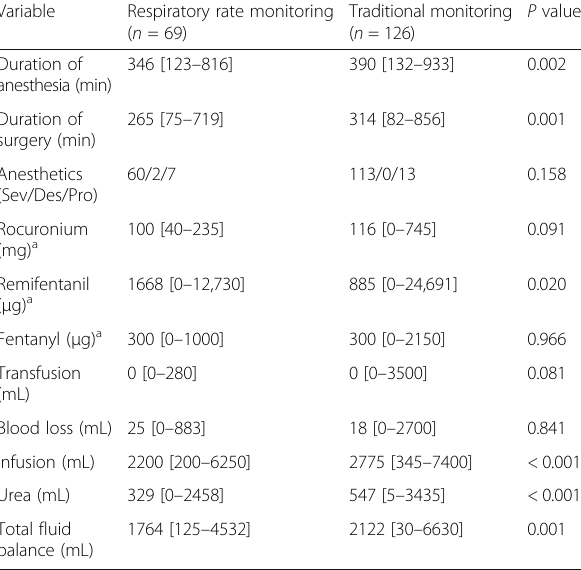
Table 3 Intraoperative data of study patients Variable